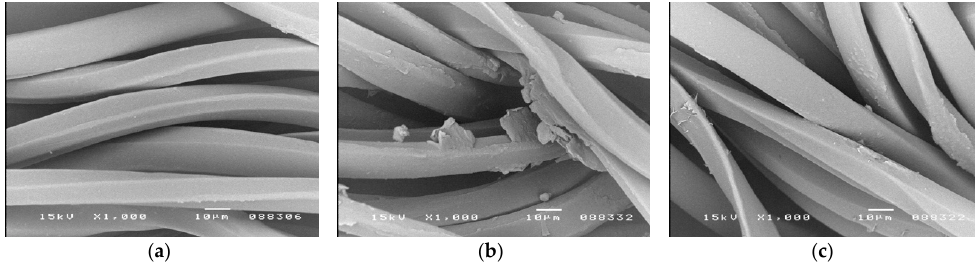
Figure 2. SEM images of polyester fibers surface before and after fabric modification (magnification 1000×); ( a )—Control sample (before modification); ( b )—After impregnation with beeswax suspension and drying at room temperature; ( c )—Sample b after heat treatment at 120 °C for 1 min. Polymers 2020 , 12 , x FOR PEER REVIEW